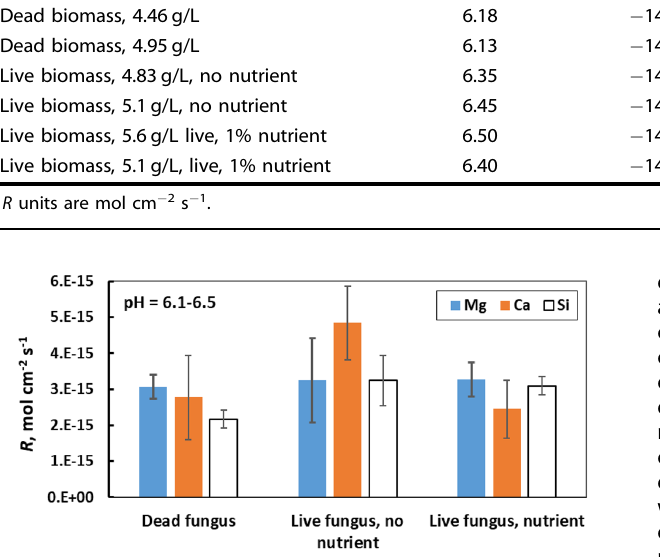
Fig. 3 Synthesis of obtained Ca, Mg, and Si release rates (average ± s.d., mol cm − 2 s − 1 ) from diopside at pH 6.0 – 6.5 with and without Chaetomium brasiliense fungus (4.5 – 5.6g wet /L) and in the presence or not of nutrients (1% Czapek medium). The error bars represent average of two reactors, each comprising 9 – 10 indepen- dent sampling as a function of time over 19 days of